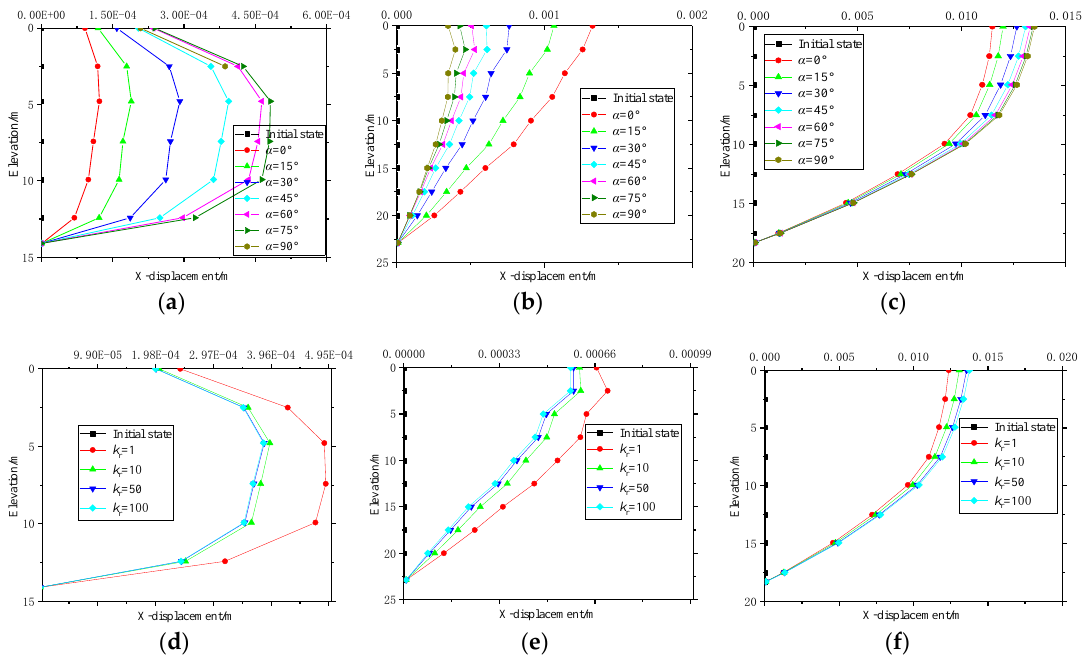
Figure 9. Variations of x -displacement under different k r and α values for clay soil. ( a ) Top of the slope with k r = 10. ( b ) Middle of the slope with k r = 10. ( c ) Toe of the slope with k r = 10. ( d ) Top of the slope with α = 45°. ( e ) Middle of the slope with α = 45°. ( f ) Toe of the slope with α = 45°.